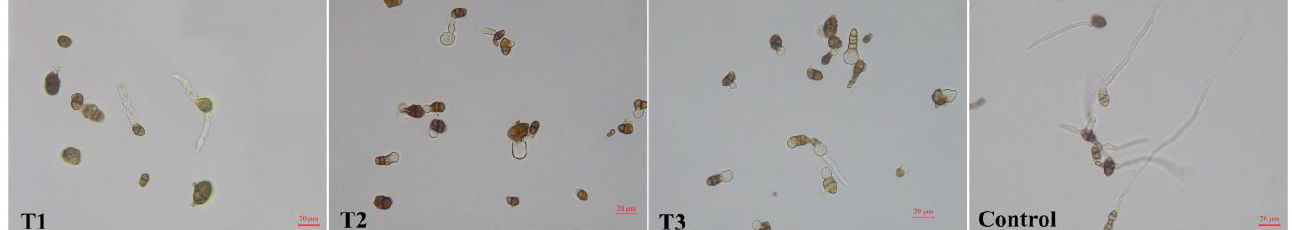
letters represented a significant difference ( p < 0.05). Table 3. Antifungal spectrum of strain J-1 and its aseptic filtrate.